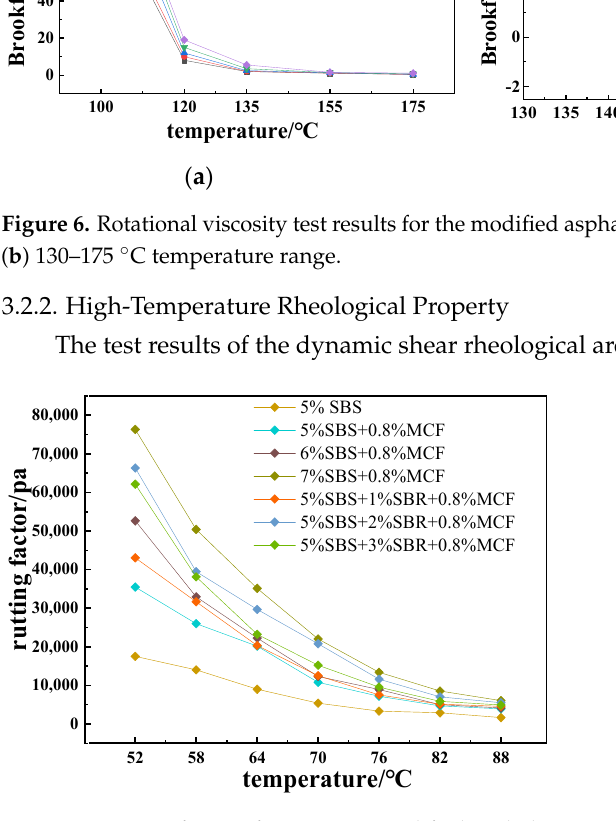
Figure 7. Rutting factor of composite-modified asphalt.